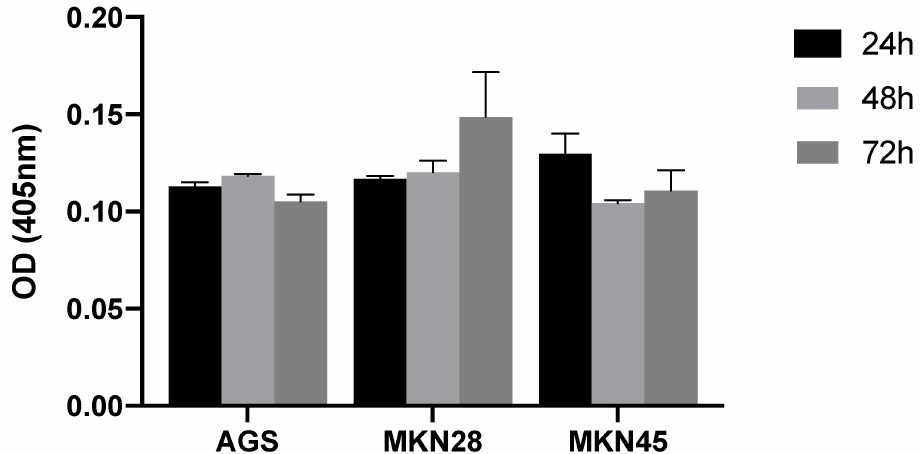
Figure 5. Results of MKN28, AGS, and MKN45 cell line senescence in β -galactosidase assay at different time points (24 h, 48 h, and 72 h). No significant association was found. OD, optical density.